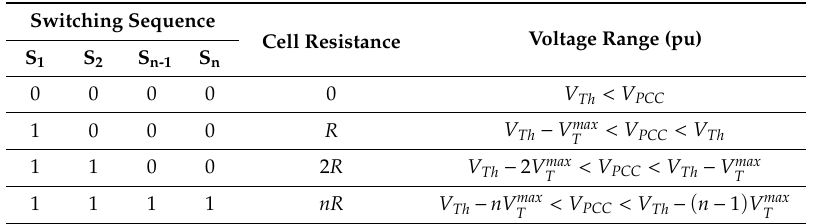
Table 1. Switching strategy.